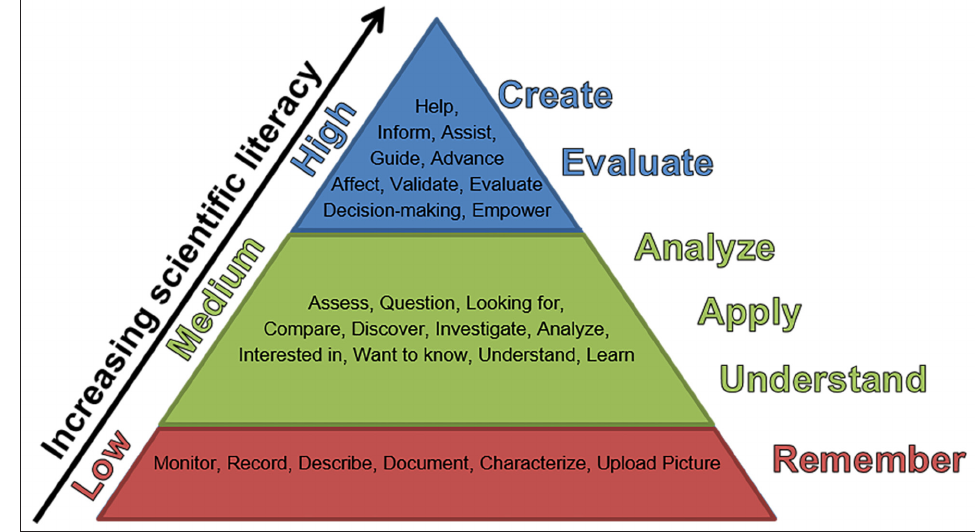
Figure 1: Bloom’s Taxonomy: an educational framework used to classify the depth of knowledge as low, medium, and high. The words and phrases above represent the tasks of the citizen science projects on CitSci.org (modified from Bloom